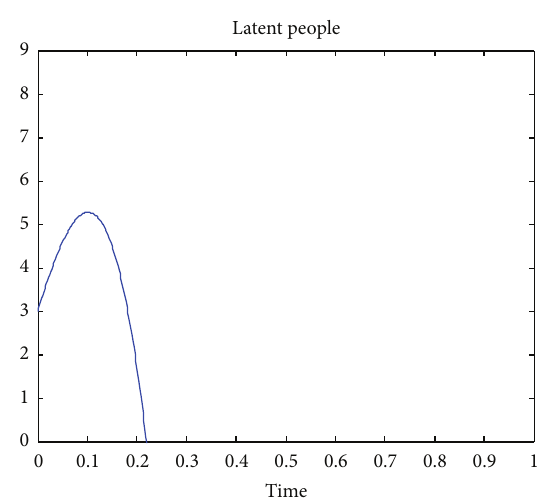
Figure 2: Approximate solution for the number of TB latently infected